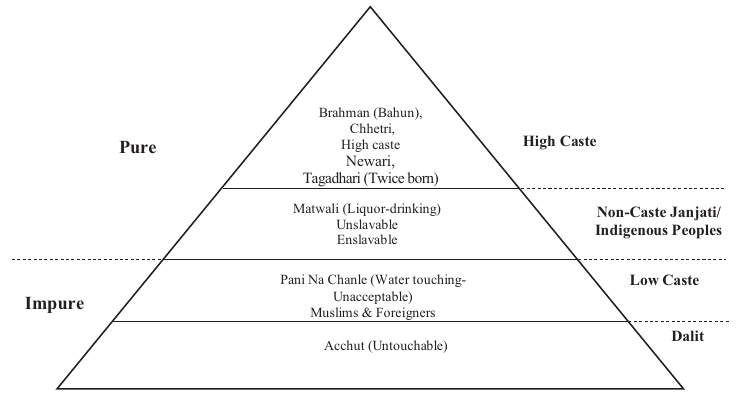
Figure 2. The Nepalese caste pyramid according to the Muluki Ain of